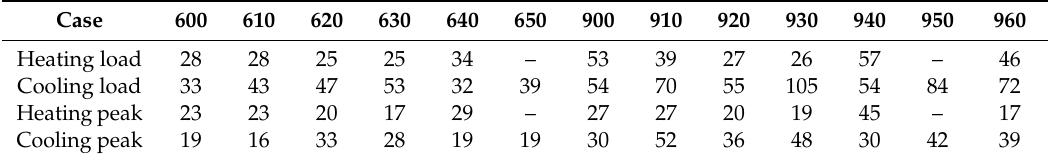
Table 12. Discrepancy (%) between the maximum and minimum BESTEST threshold values for all the qualification tests. Highest and lowest discrepancies are evidenced in